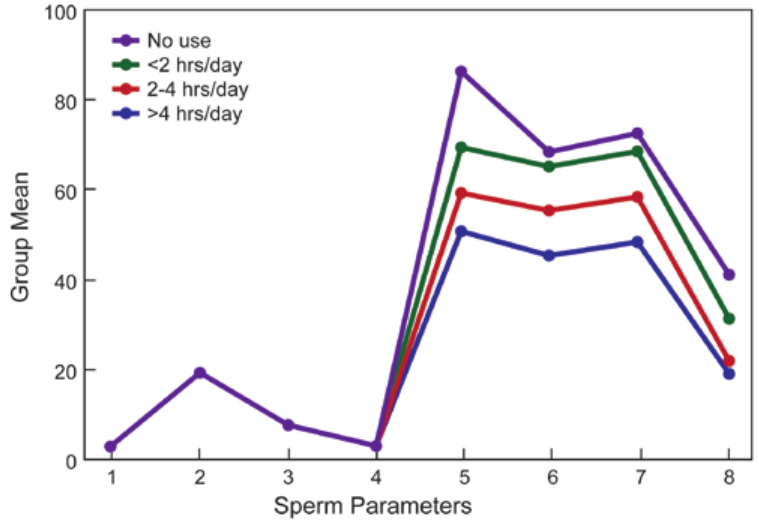
Figure 3 - Differences in semen parameters between cell phone users. The x-axis lists the eight sperm parameters which were studied between the four groups: 1 = volume; 2 = liquefaction time; 3 = pH; 4 = viscosity; 5 = sperm count; 6 = motility; 7 = viability; 8 = percent abnormal morphology. Parameters 1-3 showed not differences, whereas parameters 4-8 showed statistically significant differences between the low usage groups and the high usage groups. Adapted from Agarwal 2008